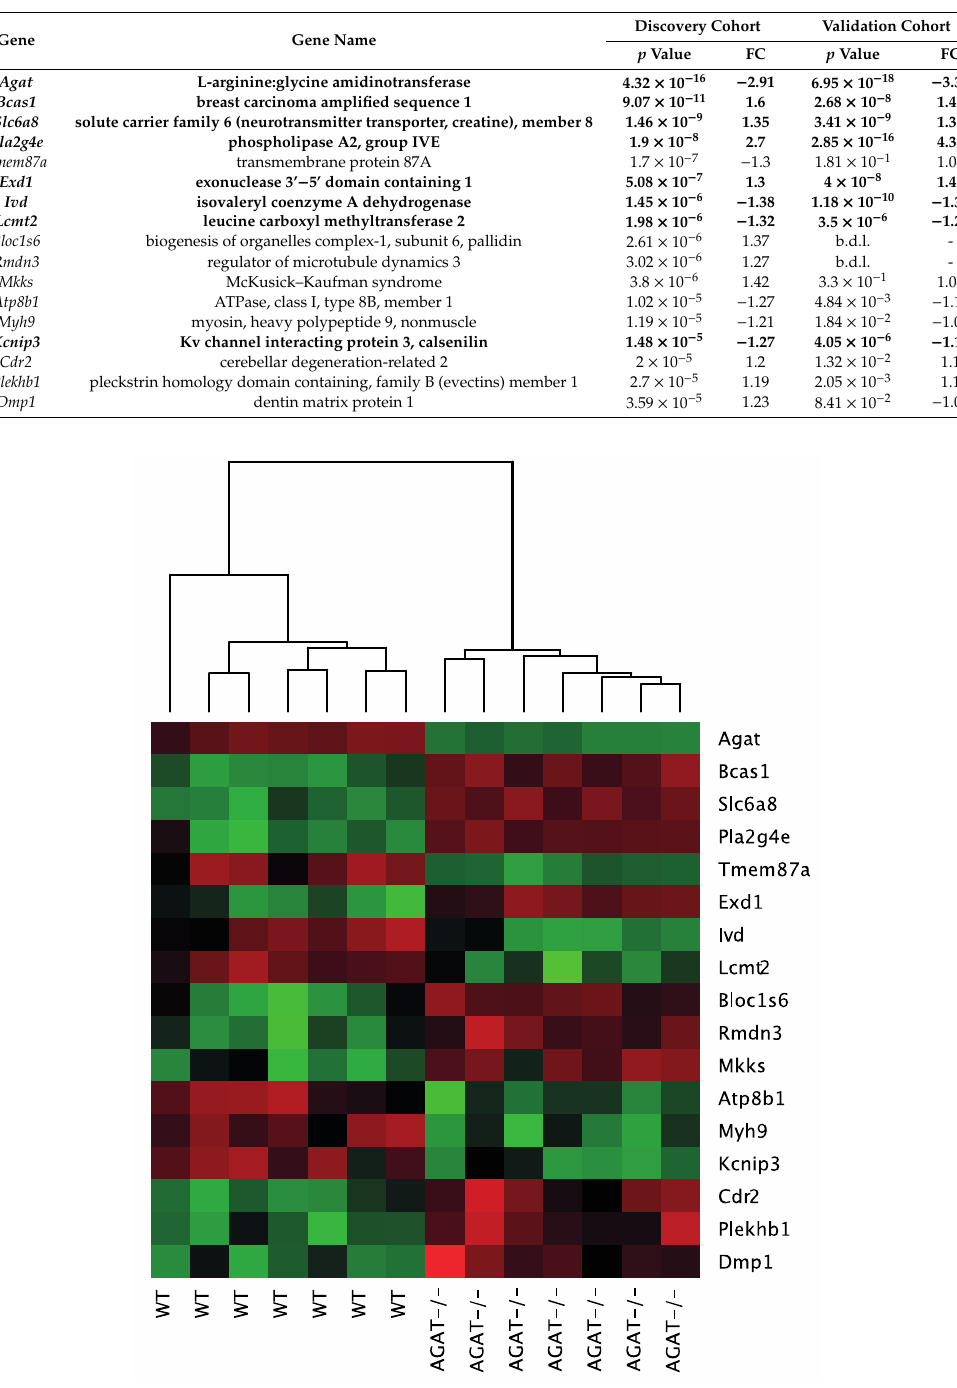
Figure 2. Heatmap of gene expression values depicting clustering of genes between WT and AGAT − / − in brain tissue samples. The heatmap is based on the expression of mRNAs for the significant genes. Low to high expression is represented by a change of color from green to red, respectively. Abbreviations: AGAT − / − , AGAT knock-out mice; WT, wild-type